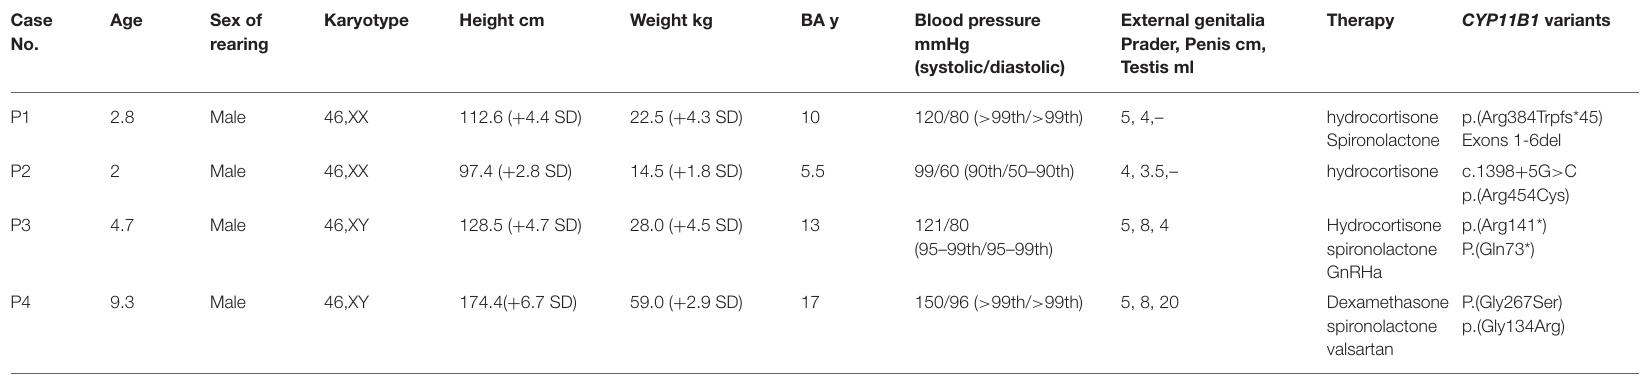
TABLE 1 | Clinical and genetic findings of four patients with 11 β OHD. Case No.